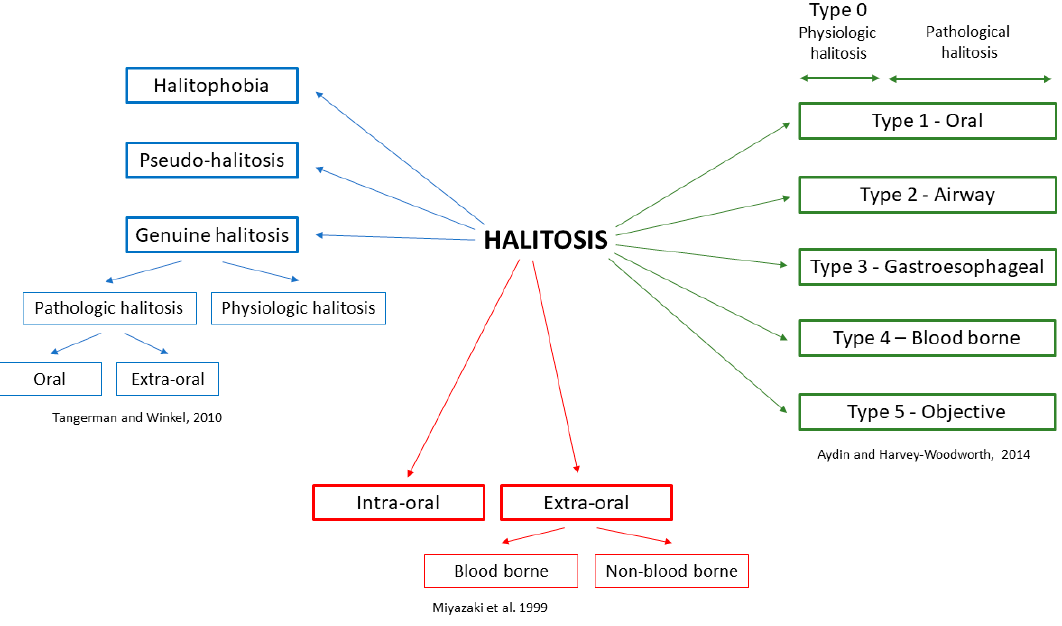
Figure 1. Classifications of halitosis [21–24].